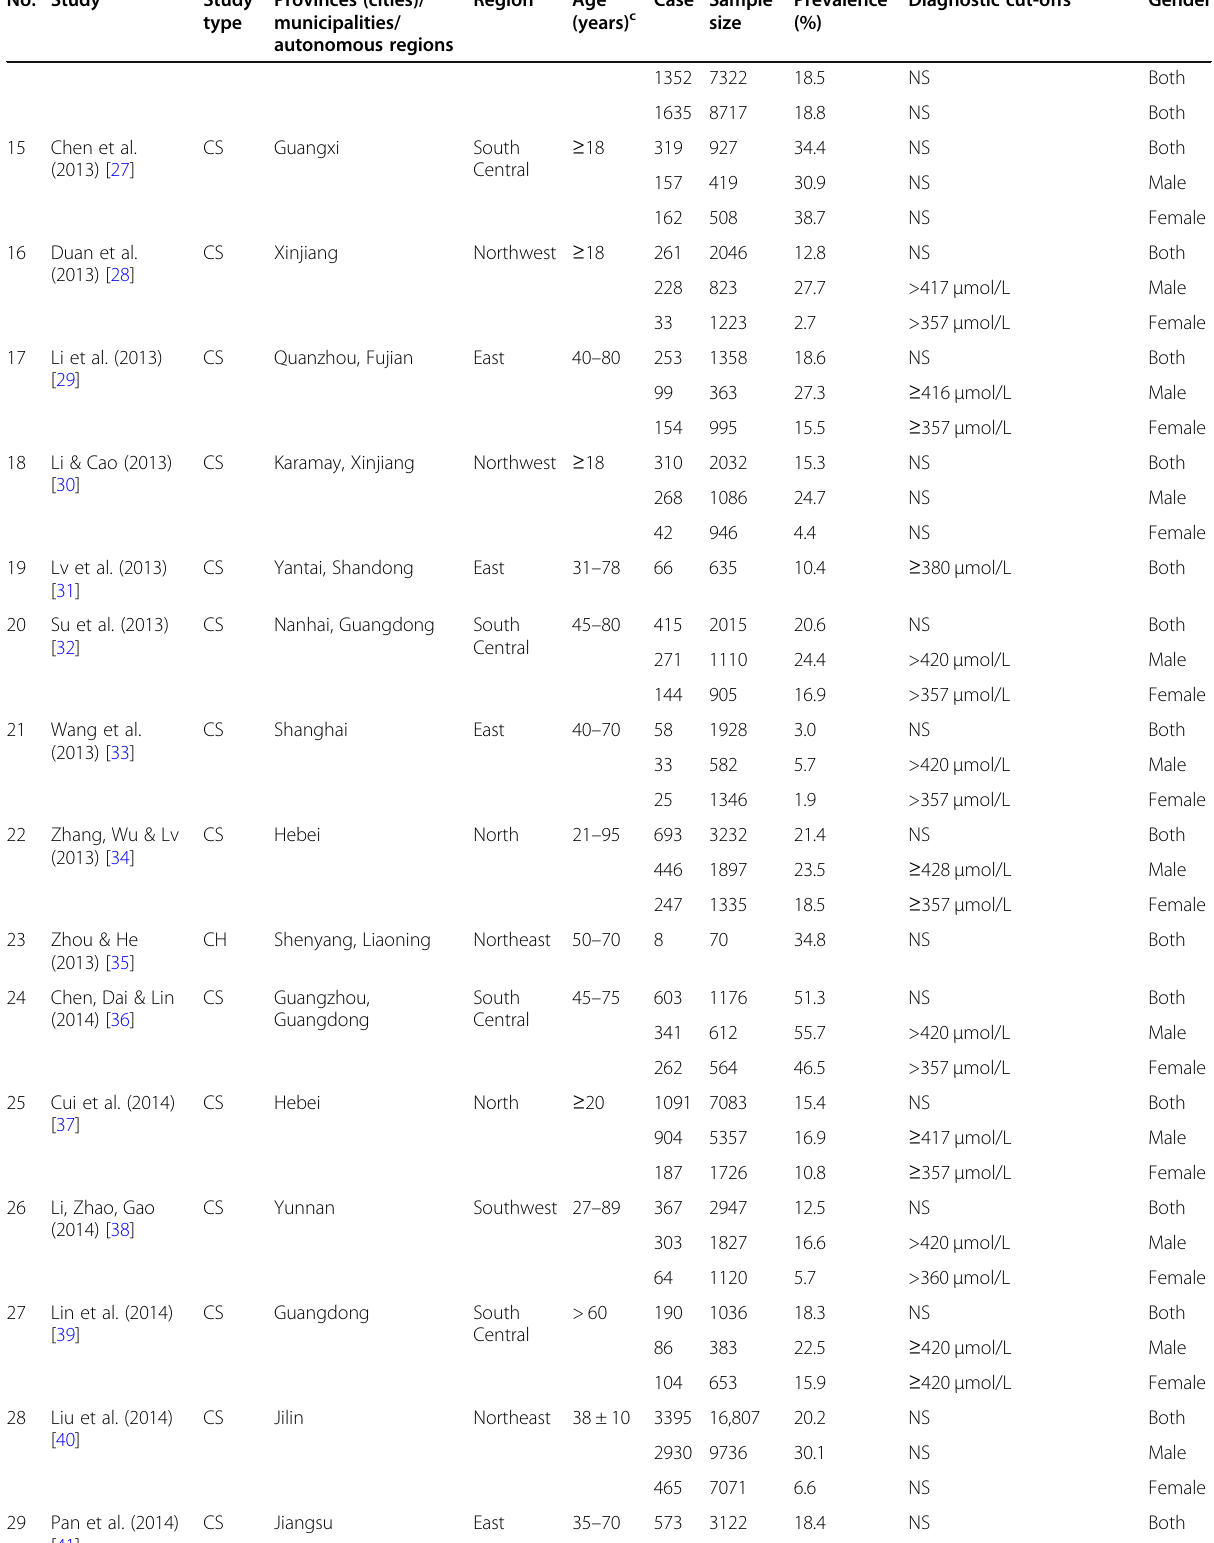
Table 1 Characteristics of the included studies in the systematic review and meta-analysis (Continued) No.